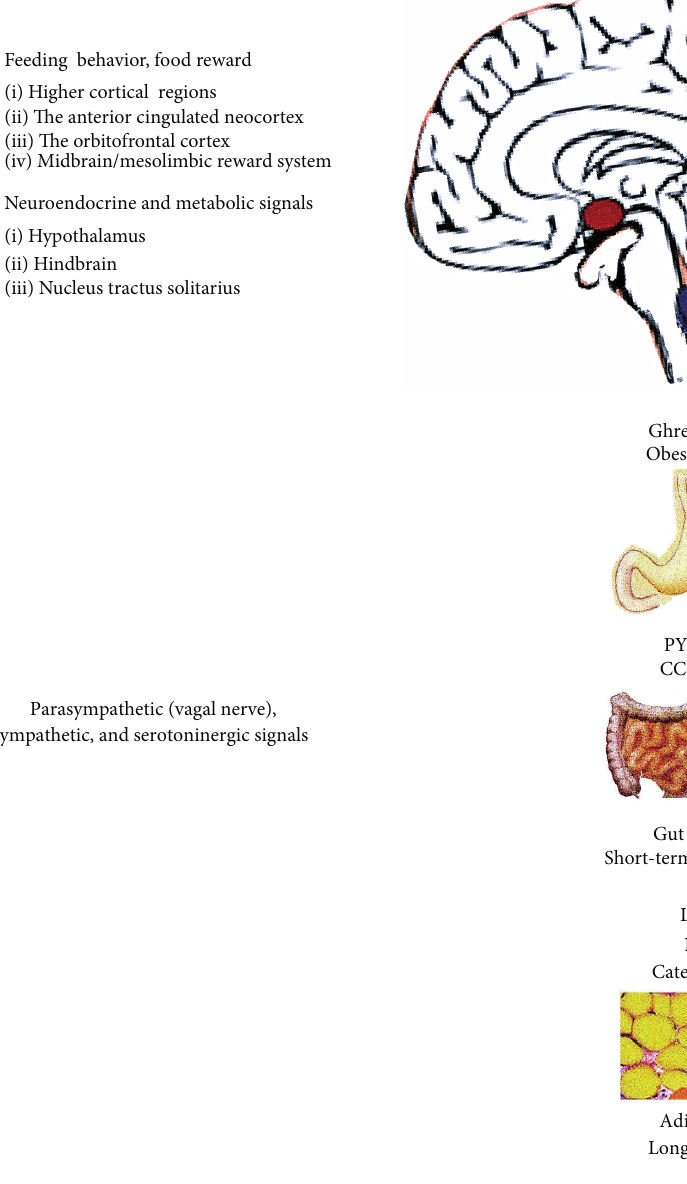
Figure1:Theroleofadiposetissue-(AT-)gut-brainaxispeptidesinlong-termandshort-termregulationoffoodintake.Long-termregulators are adipose-derived food intake-inhibiting hormone leptin or food intake-stimulating hormone neuropeptide Y (NPY) mainly produced by the hypothalamus and also cosecreted with synthesized catecholamines in AT. Hormones produced in the gut are short-term food intake- stimulating hormone ghrelin, or food intake-inhibiting peptide YY (PYY), pancreatic polypeptide (PP), cholecystokinin (CCK), insulin, and putative anorexigen obestatin (the hypothalamus (violet), nucleus tractus solitarius (NTS, blue), sympathetic and serotoninergic areas (red), and vagal nerve parasympathetic area